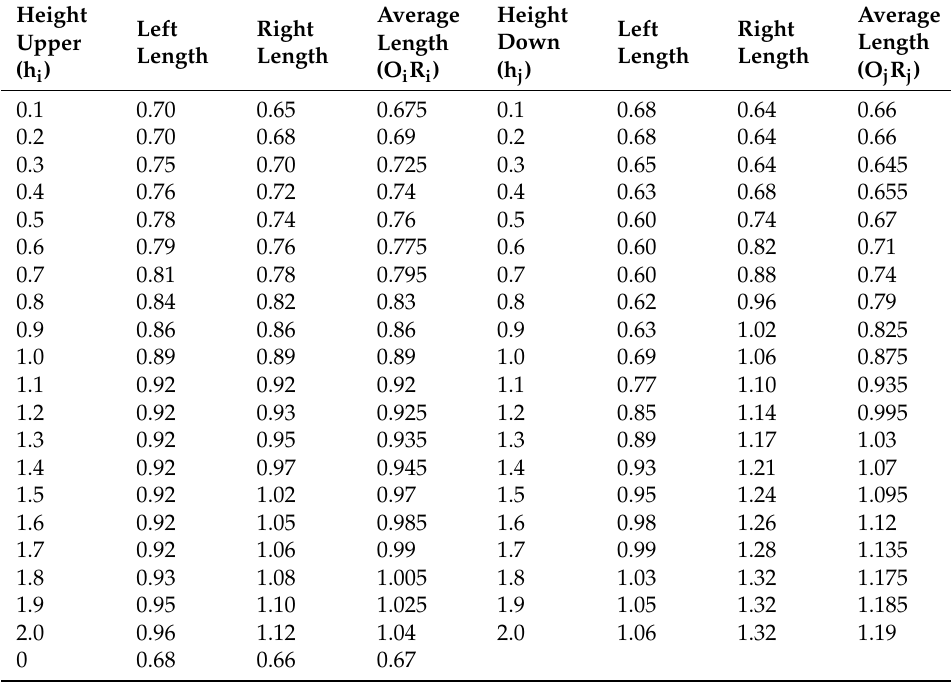
Table A4. Cross-sectional profile of case S5 weld seam. (Unit: